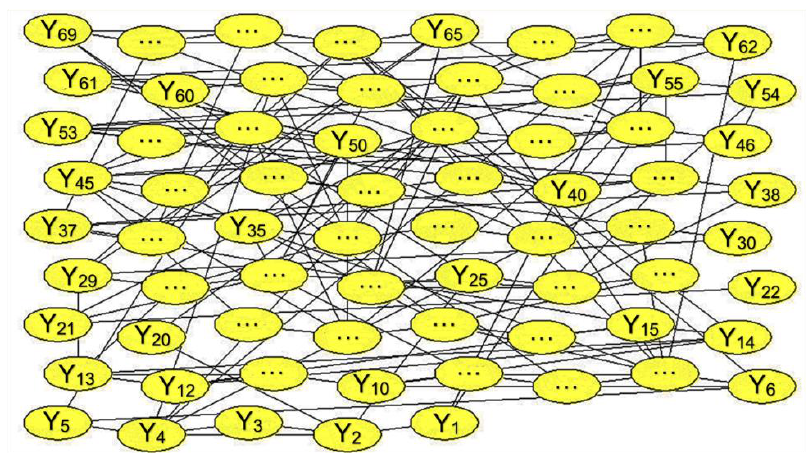
Figure 2. Causal model. Conceptual scheme for the case of a runoff time series of 69 years (from the initial year, Y 1 , to the final year, Y 69 ). The visible threshold of independence between variables is 5% (0.05), which means that up to 95% (0.95) of the dependence relationships between the variables are displayed. Each link between variables (consecutive or not, trivial or not) denotes a relationship.